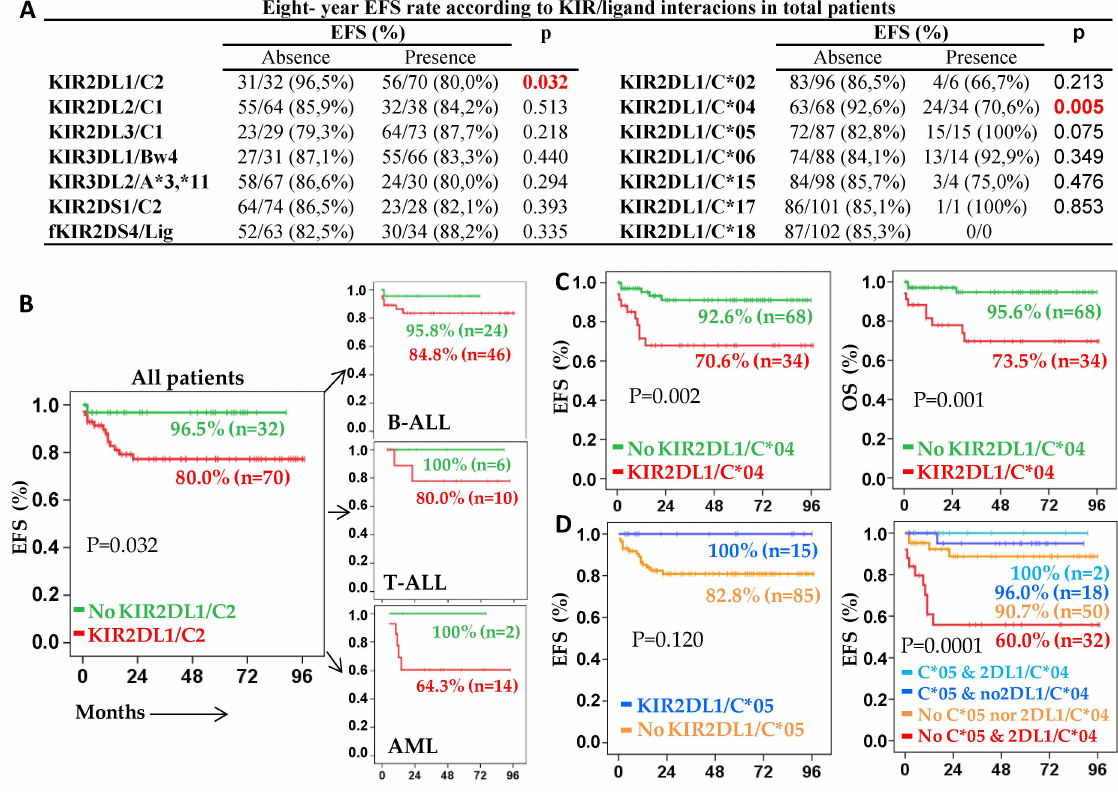
Figure 4. KIR2DL1/HLA-C2-epitope and specifically KIR2DL1/HLA-C*04 interactions are associated with reduced EFS and OS of acute leukemic pediatric patients. ( A ) Five-year event-free survival (5y-EFS) rates for KIR/HLA-ligand interaction ( left ) and for KIR/HLA-C allotypes with the C2-epitope ( right ). ( B ) Kaplan–Meier and log-rank tests for EFS of total, B-ALL, T-ALL and AML patients according to the presence of KIR2DL1/C2-epitope interaction. ( C ) Kaplan–Meier and log-rank tests for EFS and OS of acute leukemia patients according to the presence of KIR2DL1/HLA-C*04 interaction. ( D ) Kaplan– Meier and log-rank tests for EFS of acute leukemia patients according to the presence of KIR2DL1/HLA-C*05 interaction ( left ) or according to the combined presence of KIR2DL1/HLA-C*04 and KIR2DL1/HLA-C*05 interactions ( right